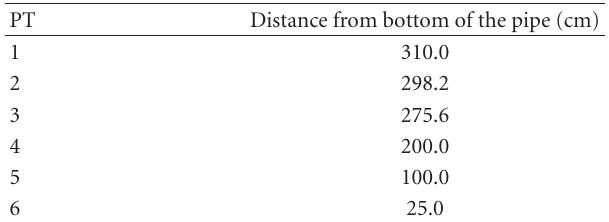
Table 1: Location of the pressure transducers